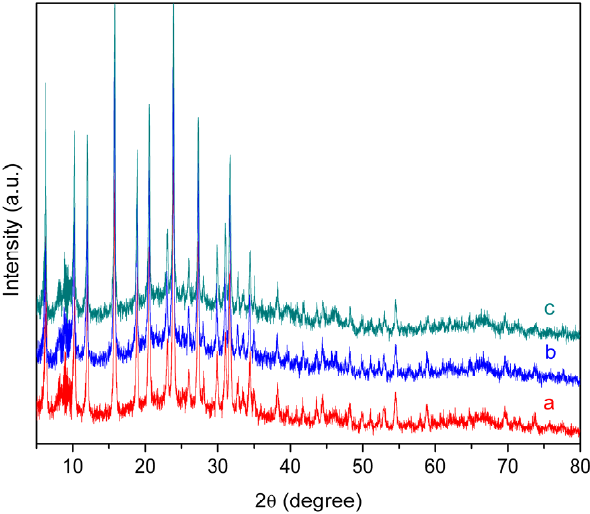
Figure 6. XRD patterns for H-USY zeolite ( a ), 0.5Pd@USY ( b ), and 1.5Pd@USY ( c )